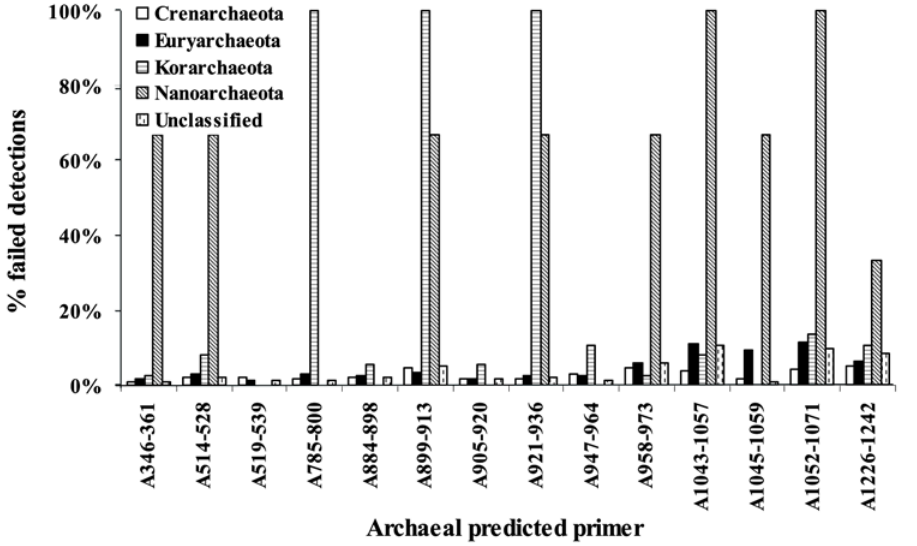
Figure 2. Phylum specificity of predicted primers for Archaea. Information on the primers is listed in Table 2. The primers were used to find their targets in 1544 Crenarchaeota, 4153 Euryarchaeota, 37 Korarchaeota, 3 Nanoarchaeota, and 878 unclassified species. The sequences without a target were classified into different phyla.